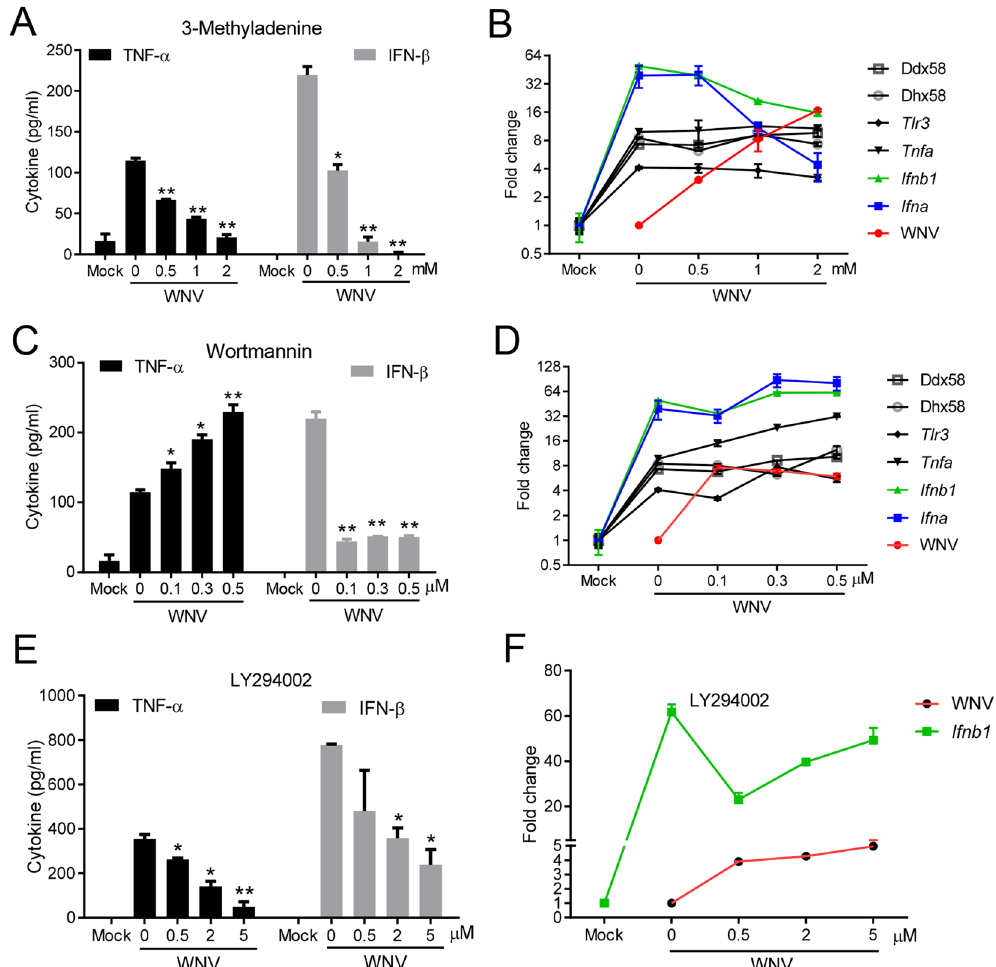
Figure 2. Inhibition of PI3K impairs WNV-induced immune responses in macrophages. BMDMs were left untreated (mock) or infected with WNV in the presence of various concentrations of ( A , B ) 3-methyadenine, ( C , D ) Wortmannin and ( E , F ) LY294002 for 24 h. ( A , C , E ) ELISA of TNF- α , IFN- β in the cell culture media. ( B , D , F ) The cellular viral loads and transcript levels of selected genes were quantified by q-PCR. The results of immune gene expression are expressed as fold induction in WNV infected cells over mock. The viral loads are expressed as fold change in inhibitor-treated over untreated cells (0). * p < 0.05, ** p < 0.001 (unpaired Student’s T-test), Bar: the mean of the result + s.e.m. The data shown are representative of 3 independent reproducible